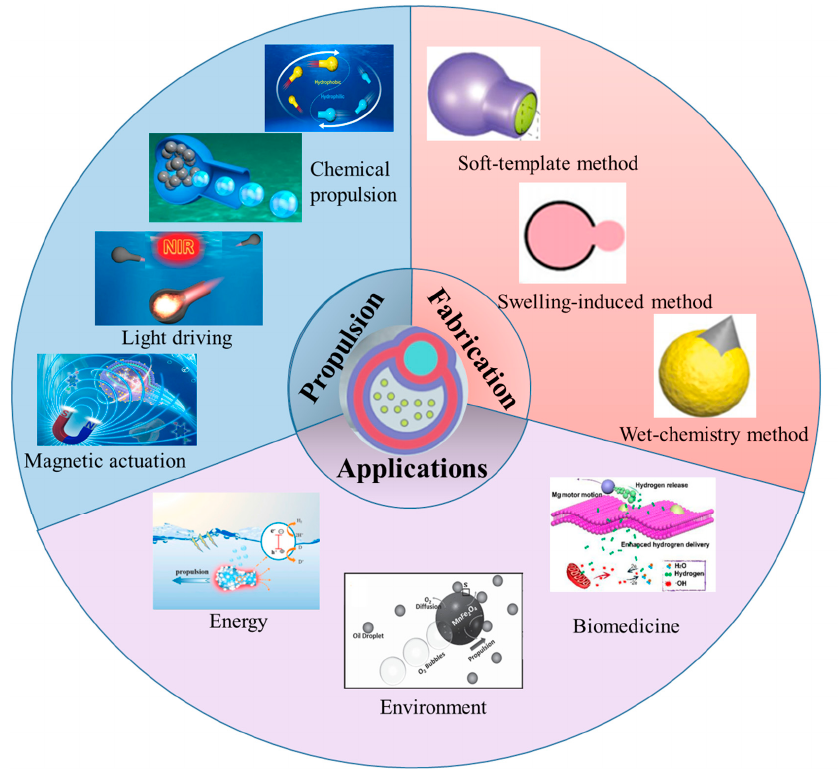
Figure 1. Nanobottles and the propulsion mechanisms, fabrication methods and potential